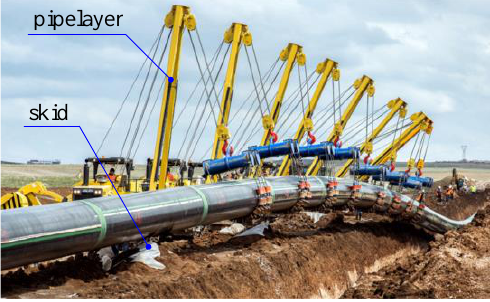
Figure 2. Pipeline during lowering-in.